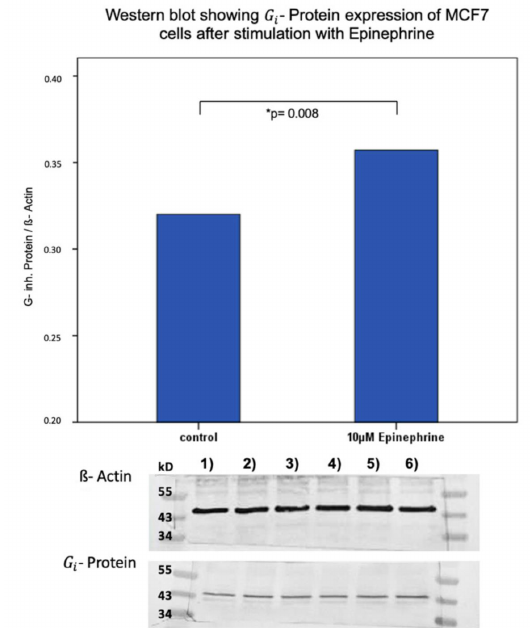
Figure 6. Western blot analysis of G i –protein expression in MCF7 cells after stimulation with epinephrine. Bar chart of G i - protein expression in MCF7 cells after incubation with 10 µ M epinephrine. Epinephrine induced a significant upregulation of G i - protein expression ( p = 0.008; * significant p -value). 1)–6) Western blot membranes after incubation with ß-actin and G i - protein antibodies.